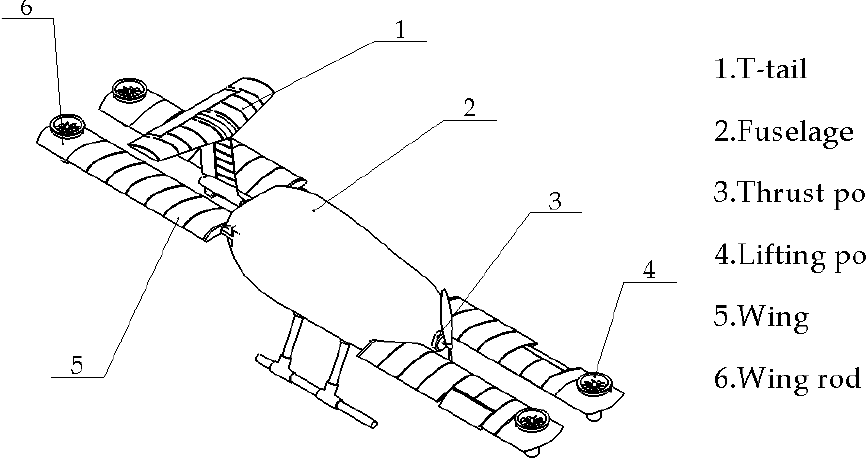
Figure 1. Structure diagram of the aircraft.